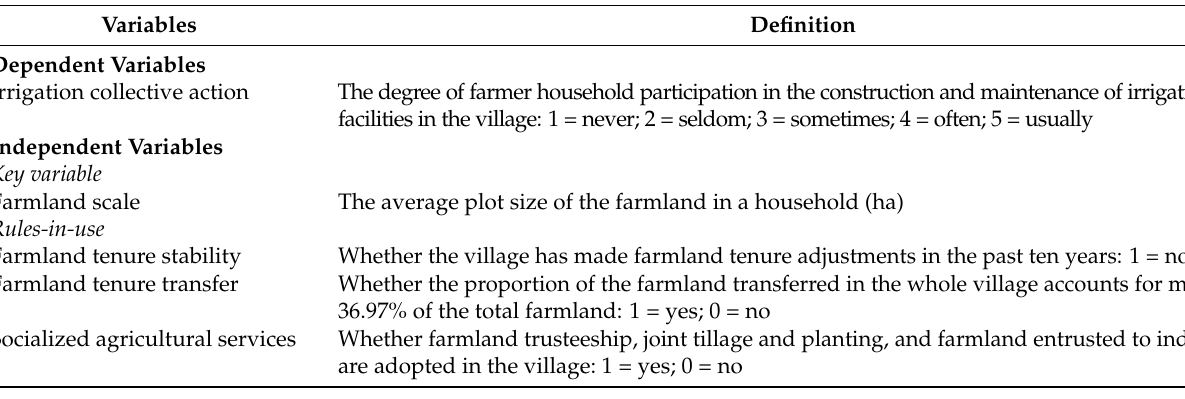
Table 1. Definition of